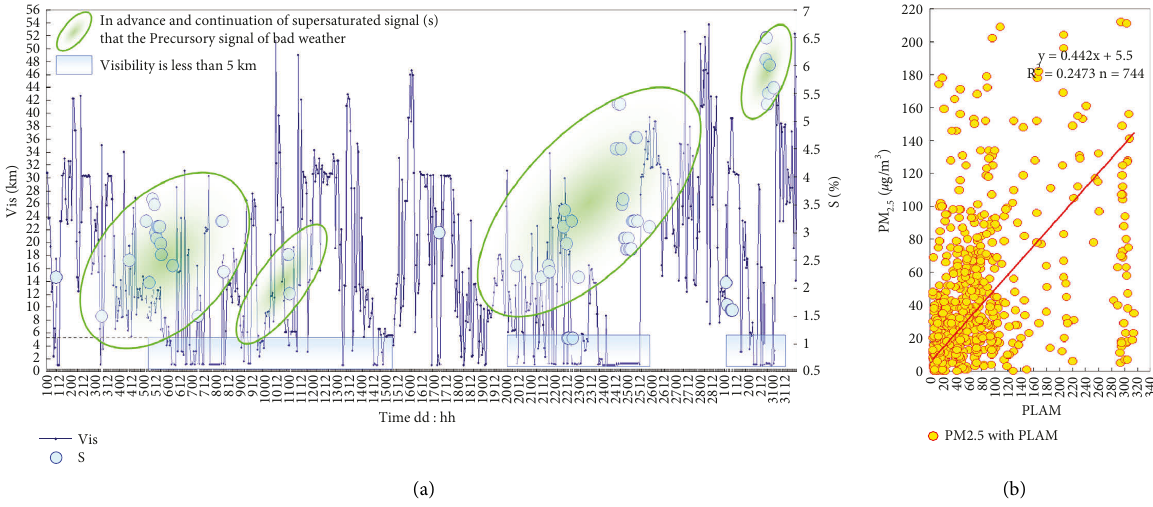
Figure 2: (a) Hour-by-hour change in visibility and precursor signal supersaturation (S) in February 2022 and (b) correlation analysis between PM2.5 and the PLAM index in February